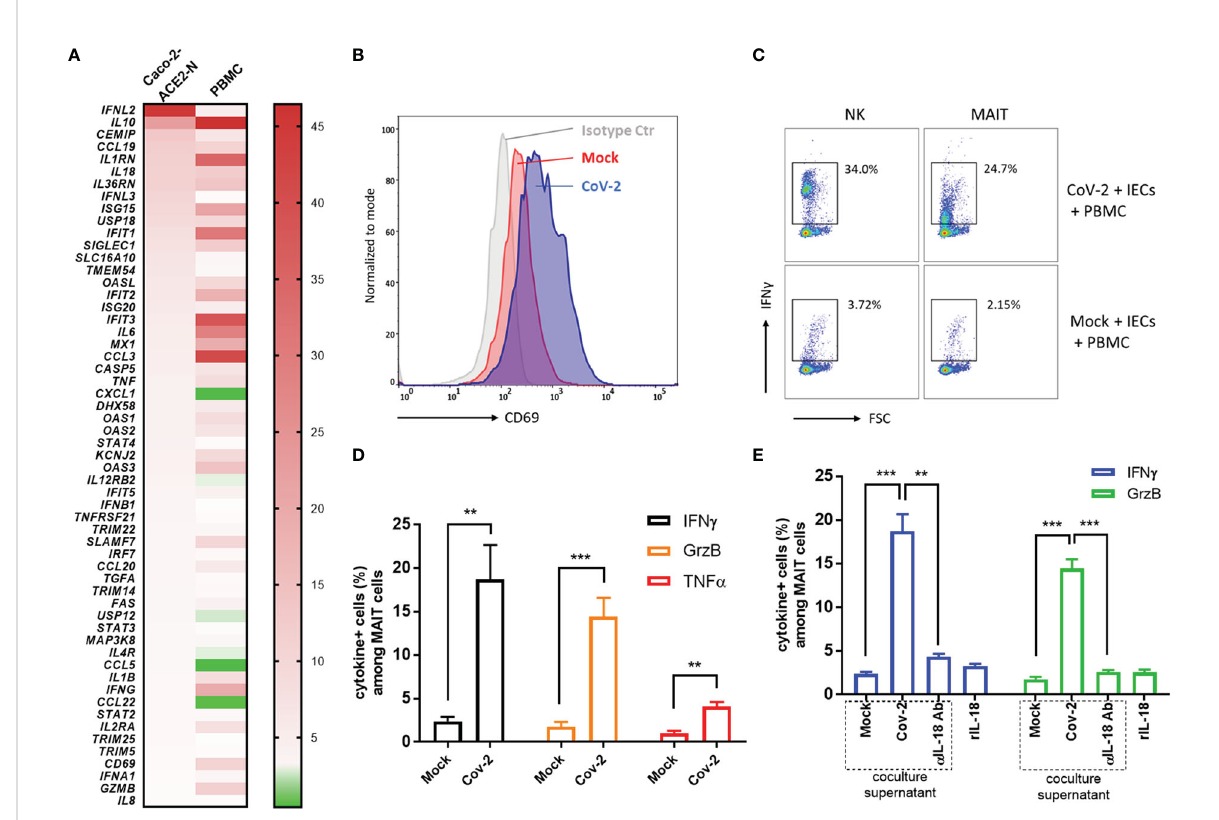
FIGURE 6 Cross-talk between CoV-2-infected epithelial cells and immune cells activated MAIT and exacerbated in fl ammation. (A) Heatmap of immunological pro fi le of Caco-2-ACE2-N cells infected with CoV-2 and PBMC cocultured with CoV-2-infected Caco-2-ACE2-N cells. mRNA fold change of immune genes was pro fi led by RT2 Pro fi ler PCR Array Gene Expression Analysis. Left panel indicated group of CoV-2-infected Caco-2-ACE2-N cells, shortly named with “ Caco-2 ACE2-N ” ; data were presented with mRNA fold change relative to Mock-treated Caco-2- ACE2-N cells. Right panel indicated group of PBMCs cocultured with CoV-2-infected Caco-2-ACE2-N cells, shortly named with “ PBMC ” ; data were presented with mRNA fold change relative to control PBMCs cocultured with Mock-treated Caco-2-ACE2-N cells. (B) CD69 expression pro fi le on MAIT cells in various coculture groups. “ Isotype ctr ” indicated isotype antibody staining; “ Mock ” group indicated MAIT cells cocultured with Mock-treated IECs (Caco-2-ACE-2-N); “ CoV-2 ” group indicated MAIT cells cocultured with CoV-2-infected IECs. (C) Representative fl ow cytometry dot plot of IFN g expression in NK and MAIT cells after coculture with either Mock or CoV-2 infected IECs (Caco-2-ACE-2-N). (D) In fl ammatory cytokine (IFN g , GrzB, TNF a ) expression in MAIT cells determined by FACS with positive population percentage. “ Mock ” indicated group of MAIT cells cocultured with Mock-treated IECs; “ CoV-2 ” indicated group of MAIT cells cocultured with CoV-2-infected IECs (E) Depletion of IL18 by adding a IL18 Ab into medium at the beginning of coculture. Cytokine expression in MAIT with depletion of IL18 in coculture or with rIL18 addition alone in PBMC culture medium. All data are represented as mean ± SEM of three replicates. Statistical signi fi cance is indicated. (ns, not signi fi cant, **p<0.01 ***p<0.001, unpaired t test or One-way